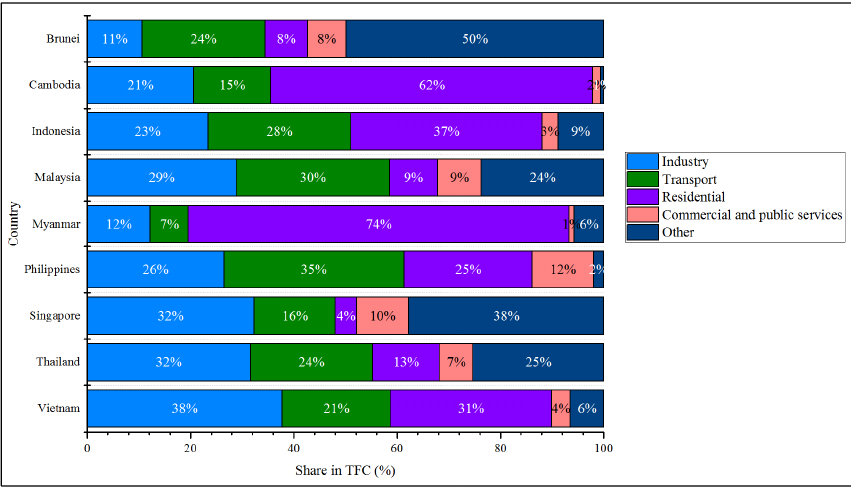
Figure 23. Sectoral energy consumption